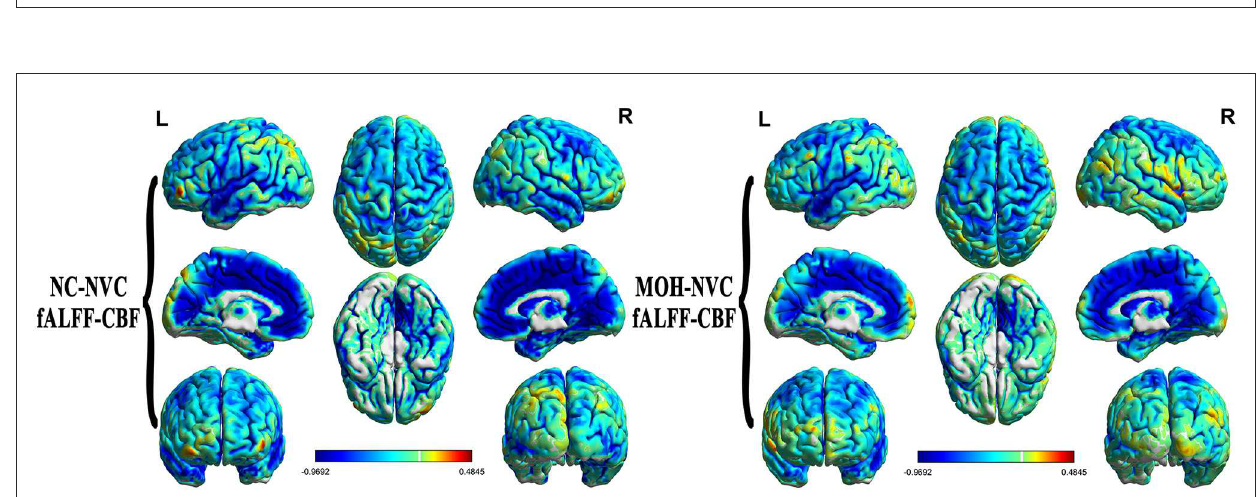
FIGURE7 fALFF–CBF connectivity, mainly indicating a negative correlation in normal controls (NCs) and patients with medication-overuse headache (MOH), and also showing no significant difference over the entire gray matter level.